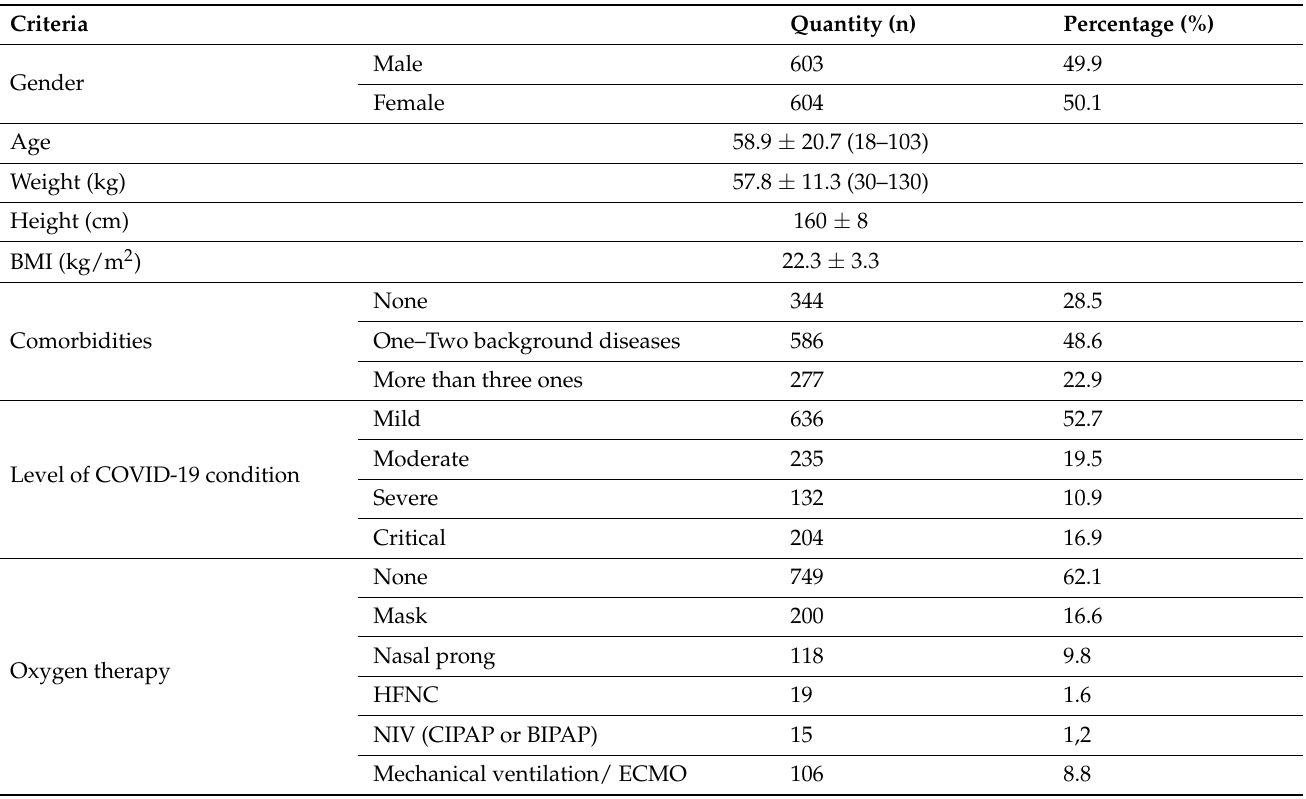
Table 1. Demographic characteristics of the study